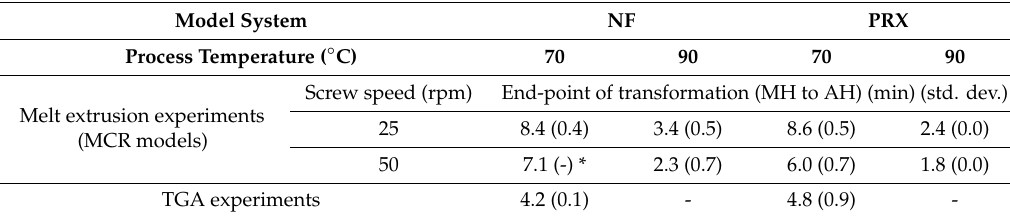
Table 1. End-point of transformation (MH- > AH) in minutes (defined as 95% change in MH containing samples) as calculated from the MCR models of in-line Raman spectroscopy and from TGA experiments, reported as average values with standard deviation in brackets, n =